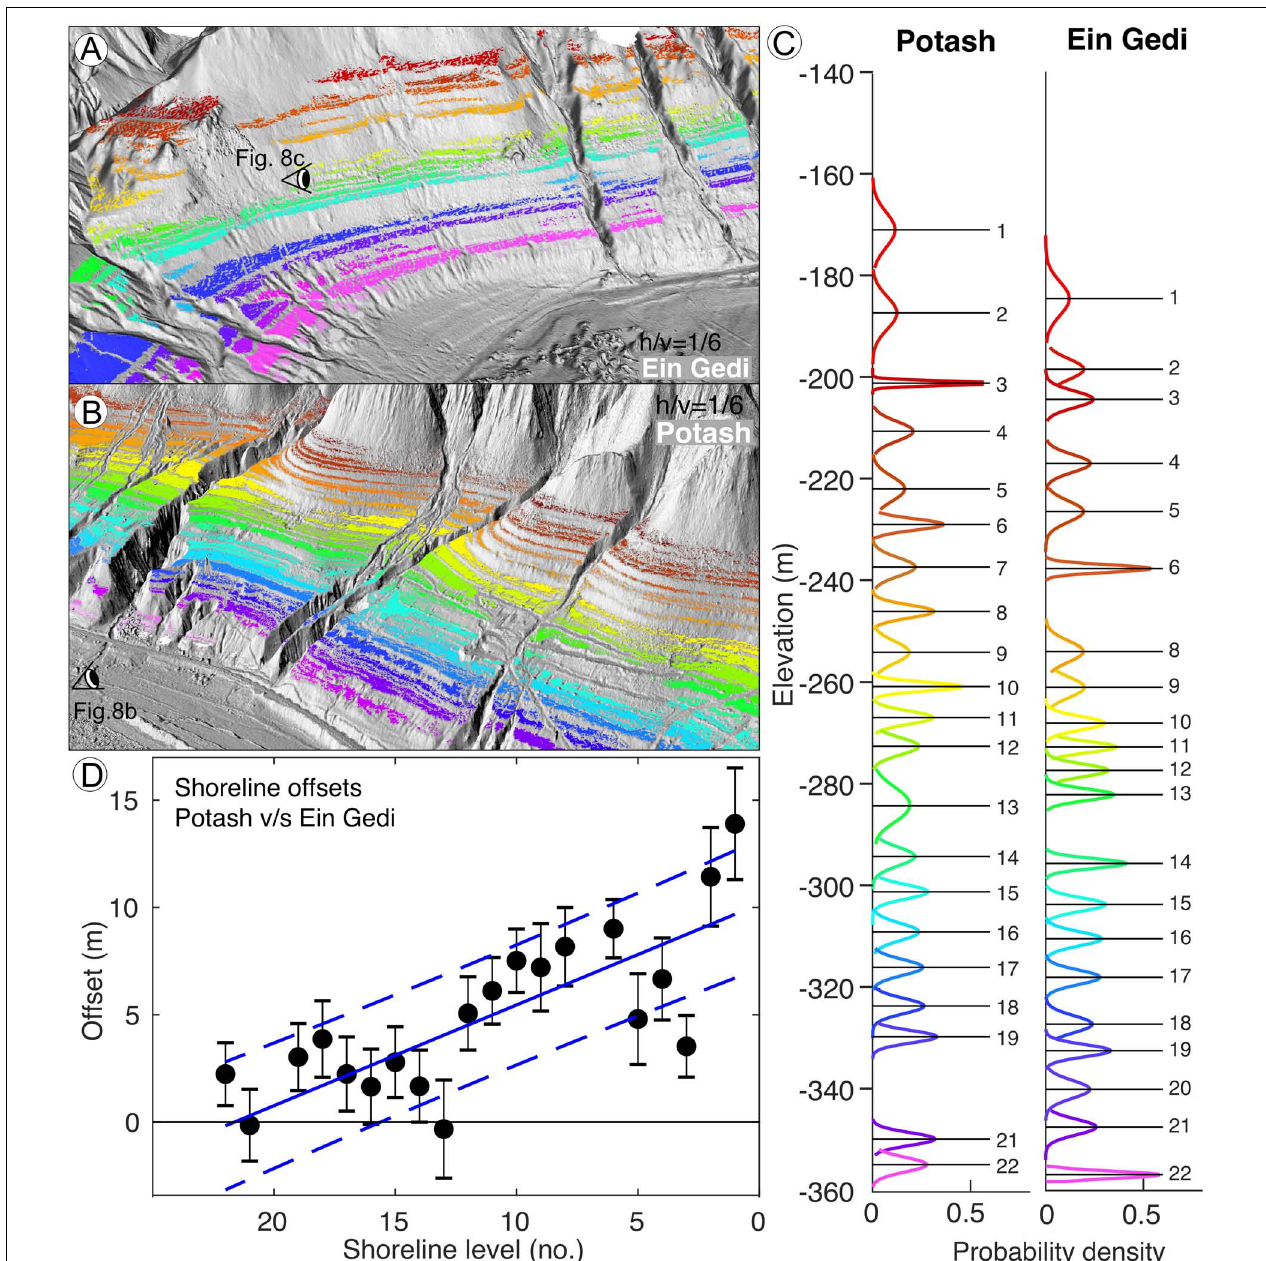
FIGURE 9 | Results of the morphometric analysis of Dead Sea lacustrine shorelines at Ein Gedi (Israel) and Potash (Jordan) sites. (A,B) 3D perspective views of SCM mapping using high-resolution SfM topography, h/v is the proportion between vertical and horizontal scales. (C) Distribution of elevations of fossil lacustrine shorelines at Potash and Ein Gedi. (D) Vertical offsets between Potash and Ein Gedi shorelines, assuming continuity and no reoccupation; blue dashed lines show the 95% confidence bounds of the linear regression (see text for details).